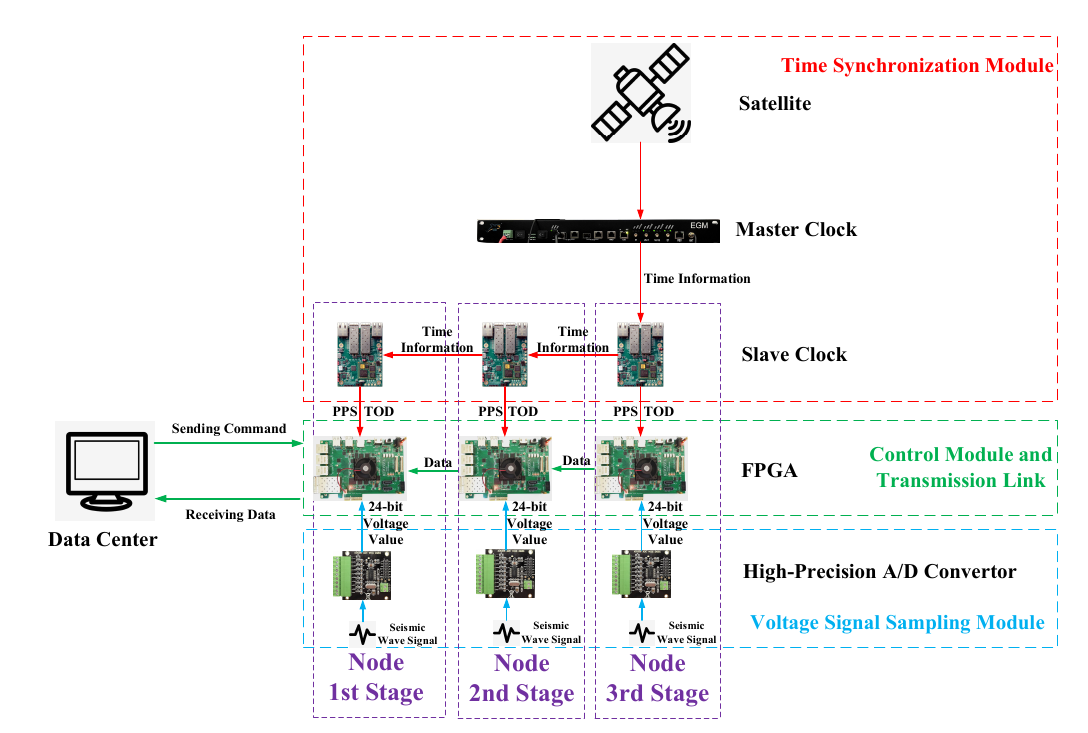
Figure 1. System block diagram of SQSTS.